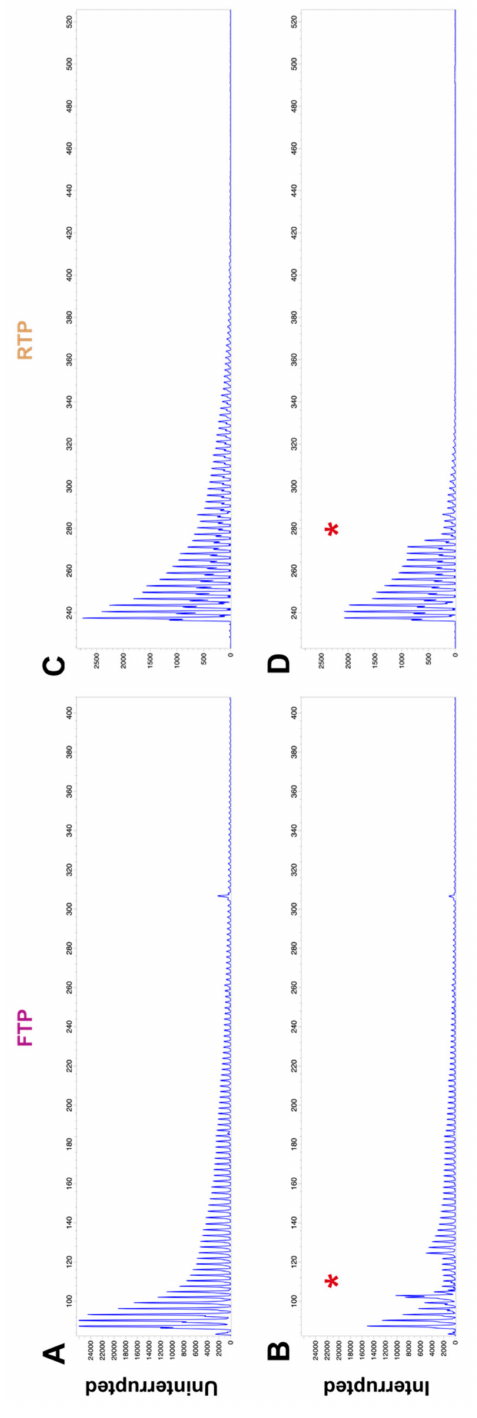
Figure 1. Example Forward and Reverse TP PCR electropherograms showing uninterrupted and interrupted repeat traces. ( A ) Uninterrupted FTP electropherogram for an individual with 450 and 720 GAA repeats. ( B ) FTP electropherogram for an individual with 200 and 1000 GAA repeats, showing a drop in signal indicating a 3 (cid:48) interruption (*). ( C ) Uninterrupted RTP electropherogram for the same individual as shown in ( A ). ( D ) RTP electropherogram for an individual with 1100 and 1200 GAA repeats, showing a drop in signal indicating a 5 (cid:48) interruption